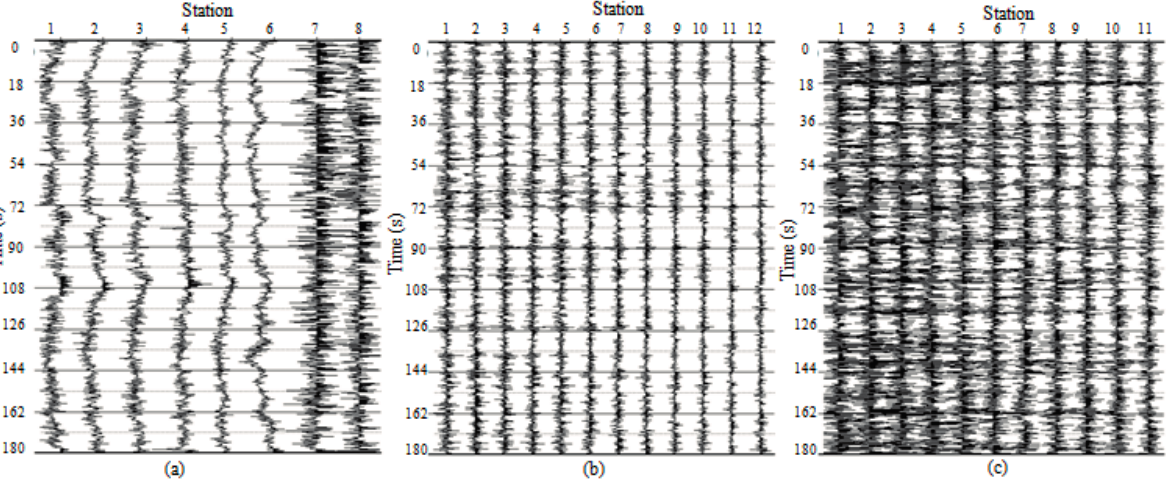
Figure 8. Typical time history series from: ( a ) accelerometer; ( b ) cableless geophone; and ( c ) 4.5 Hz geophone.